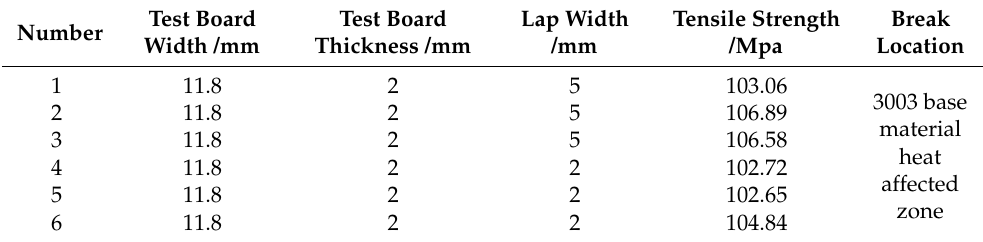
Table 3. Mechanical properties of brazed joints with different lap